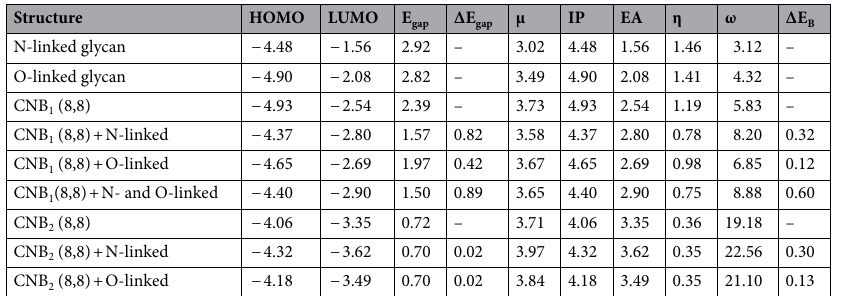
Table 3. HOMO and LUMO level energies, HOMO-LOMO gap (Egap), change in HOMO–LUMO gap in the presence of glycan molecules (∆ E gap) respect to pristine CNB, chemical potential (μ), ionization potential (IP), electron affinity (EA), chemical hardness (η), and electron felicity (ω). All quantities are given for both pristine CNB and CNB in the presence of N-linked and O-linked glycans. ∆ E B shows binding energy of glycan molecules to CNBs. All quantities are given in eV.